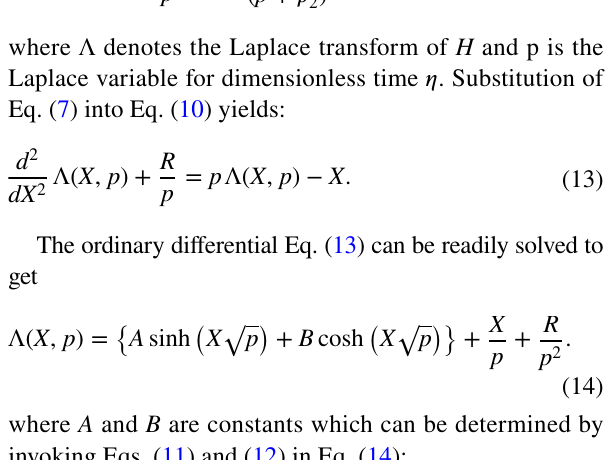
Fig. 2 Profile of the river level with h s = 18 m and h 0 = 1